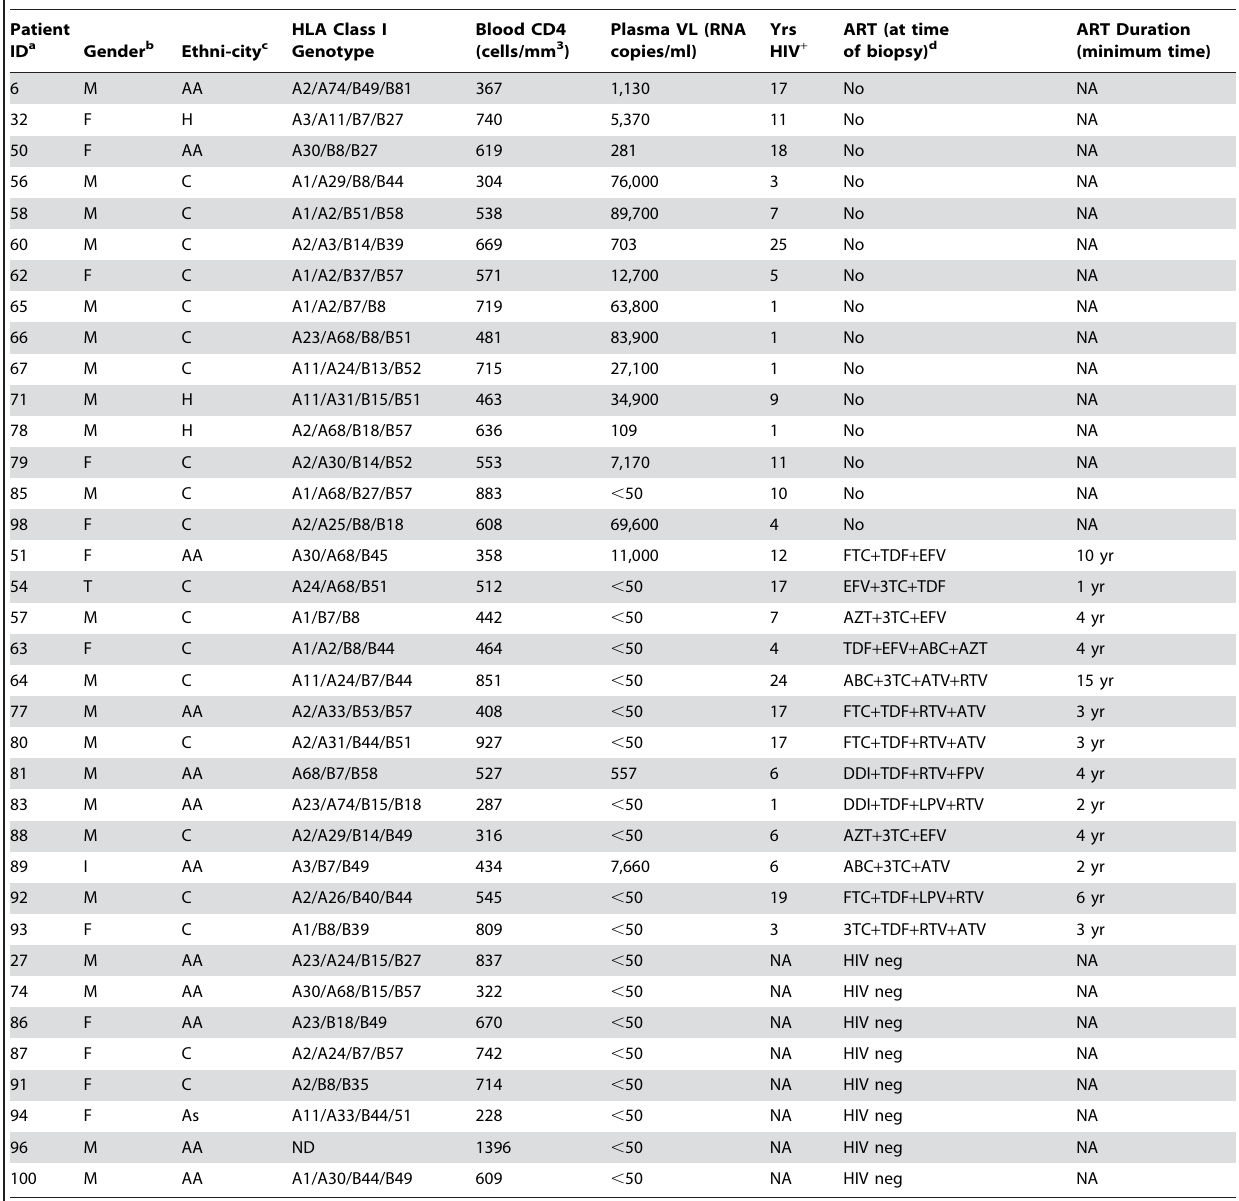
Table 1. Patient